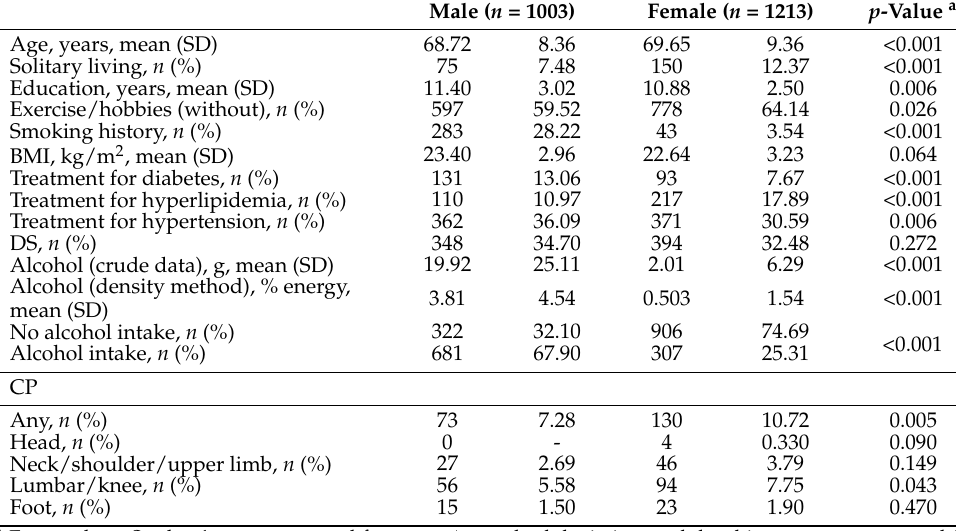
Table 1. Participant